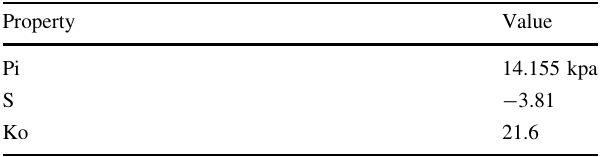
Table 3 Convolution simulated